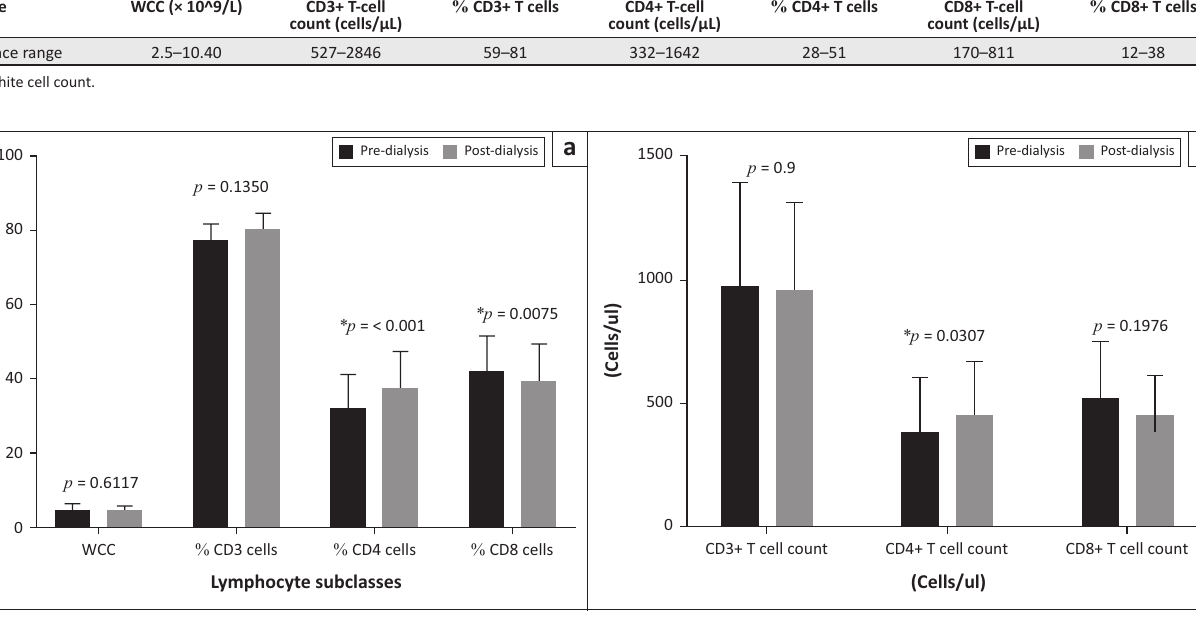
The other measured parameters revealed no statistically significant change (Figure 2). Figure 2: Measured parameters of study controls pre- and post-dialysis Following a cross-sectional analysis, the longitudinal trends for the percentage of CD4+ T cells, the absolute CD4+ T-cell counts and the HIV viral loads were analysed for each patient. The initial available CD4+ T-cell count was taken as point zero. Although the exact date when haemodialysis